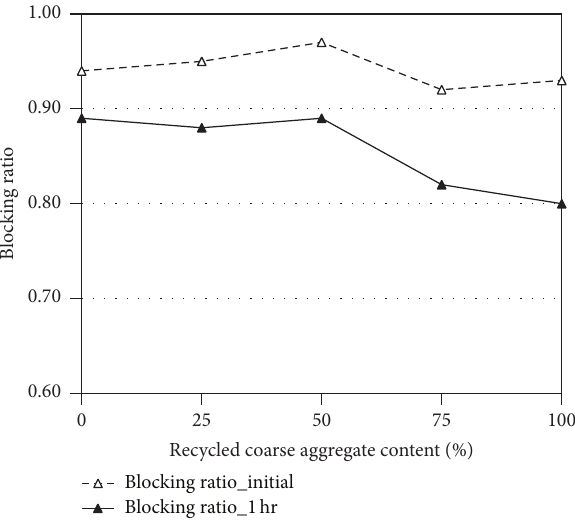
Figure 4: Effect of RCA content on blocking ratio of SCC mixes.